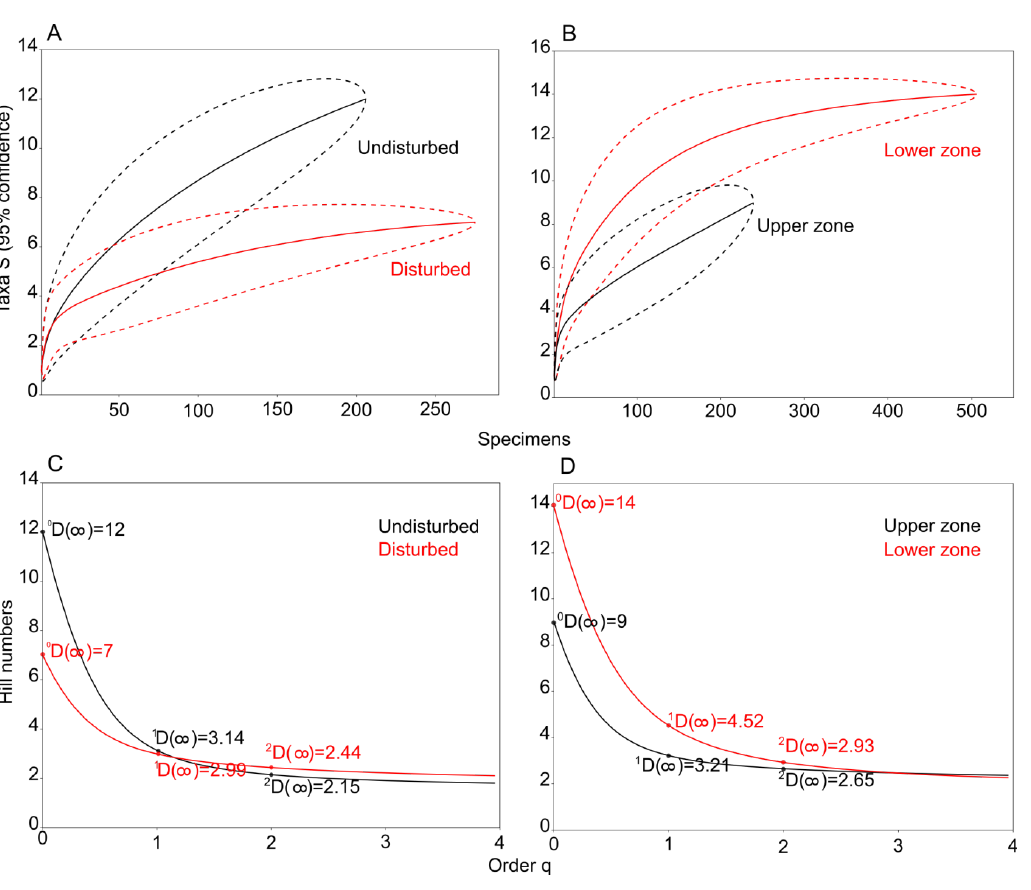
Figure 4. Rarefaction curves with 95% confidence intervals for species richness of bats (A, B) and diversity profile curve plotting Hill numbers (C, D) for the undisturbed and disturbed coniferous forests and the forests of the upper and lower zone in the Polish Tatra Mountains, 2016 – 2020.